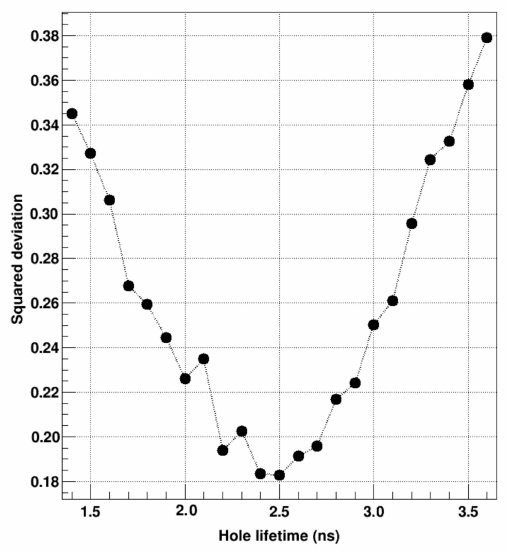
Figure 8. Squared deviation between experimental and simulated data of the negative signal tail of the correlation plots as a function of the hole